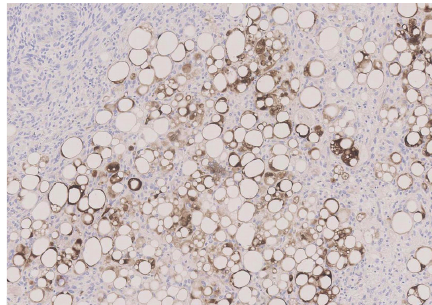
Figure 7: S100 immunohistochemical stain positive in the lipoblas- tic component ( × 10